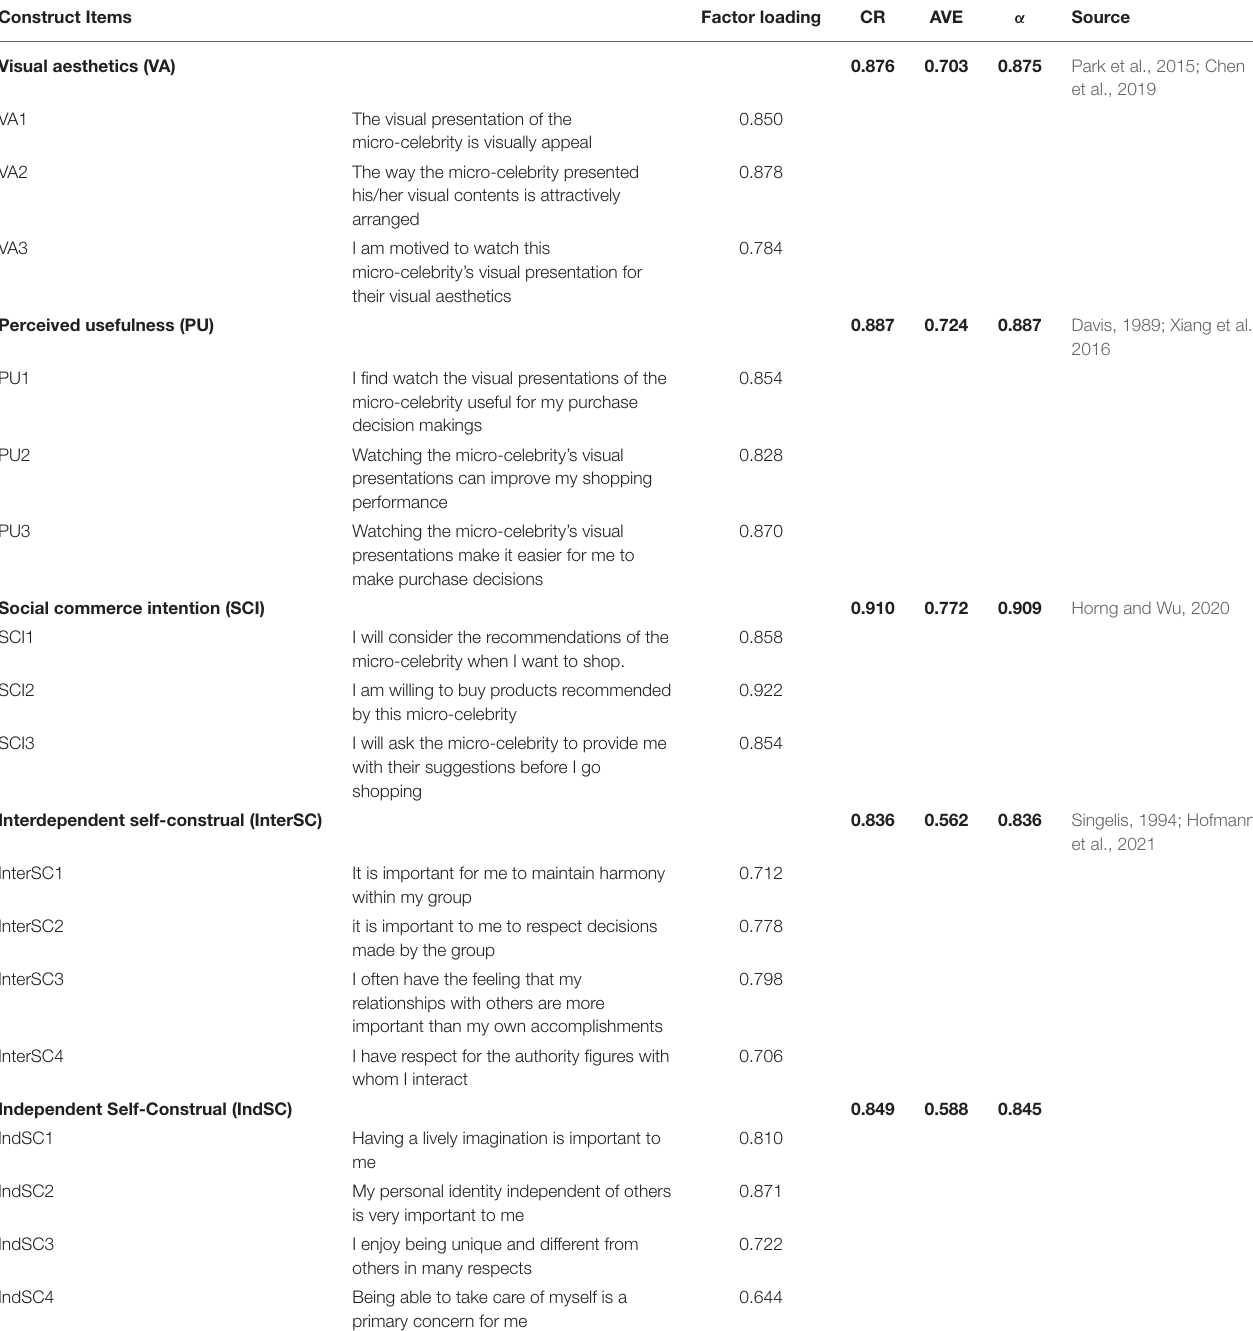
TABLE 1 | Main variable measurement items, reliability, and factor loadings. Construct